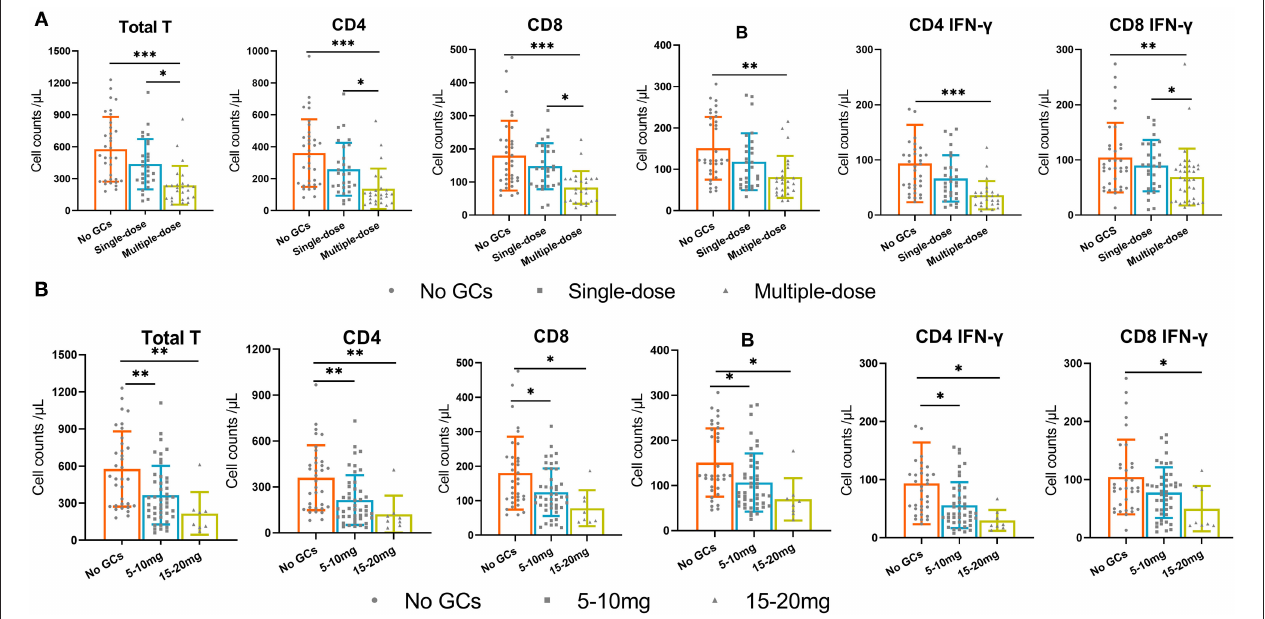
FIGURE 3 | The absolute numbers of total T cells, CD4 + T cells, CD8 + T cells, B cells, and IFN- γ producing CD4 + T cells and CD8 + T cells in three groups. (A) the no GCs group, single-dose group, and multiple-dose group. (B) the no GCs group, 5–10mg group, and 15–20mg group. * p < 0.05, ** p < 0.01, *** p < 0.001.